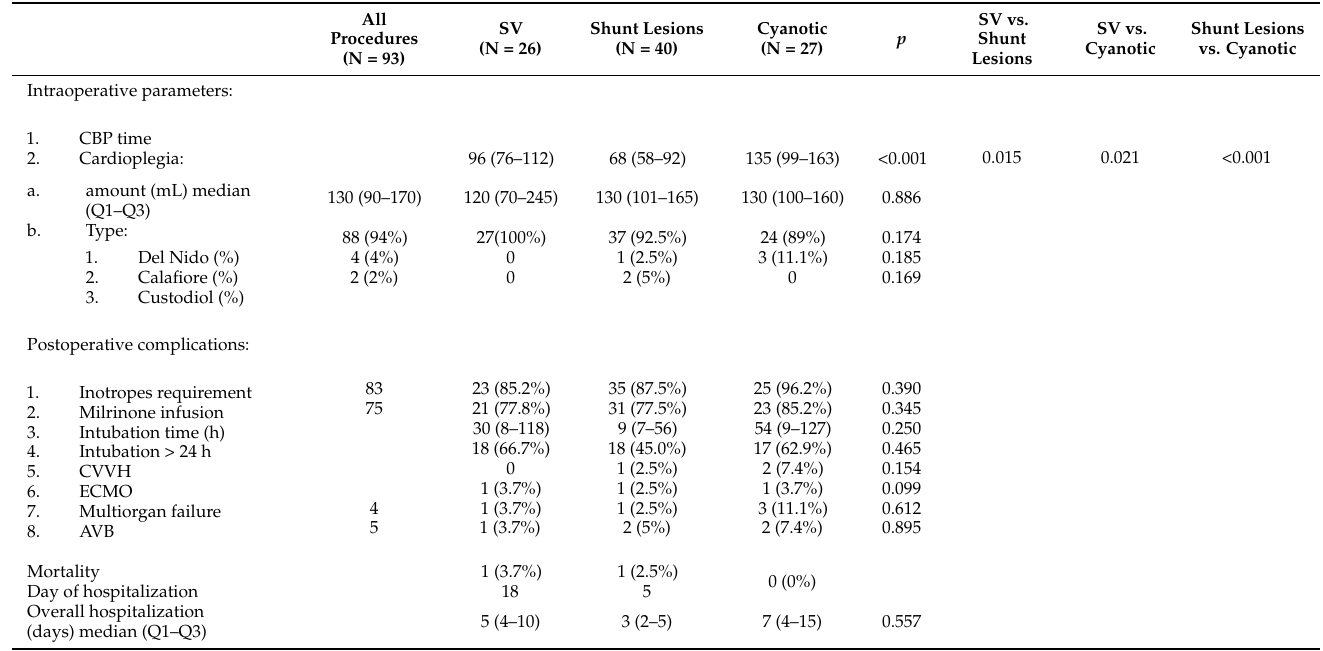
Table 1. Intra- and postoperative results in presented groups.